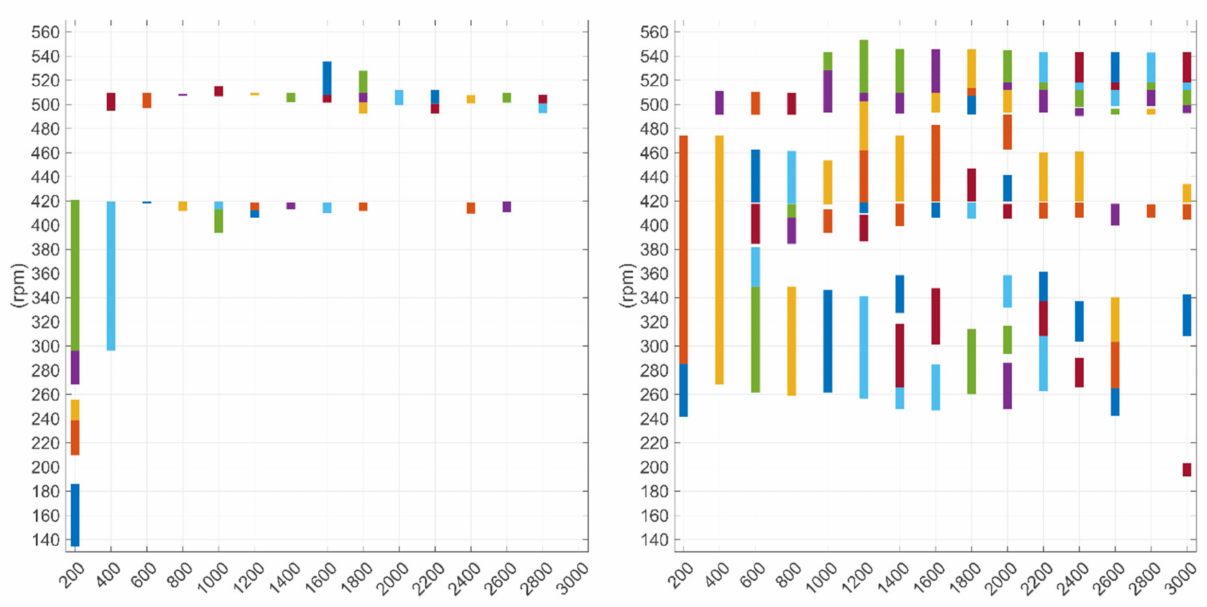
Figure 9. Selected rotational speed ranges when all models were identified together. ‘Basic training subsets’ approach was used on the left, whereas ‘adaptive training subsets’ was used on the right. Values on horizontal axis represent the sample size (N) and the vertical lines with different colors represent selected non-overlapping